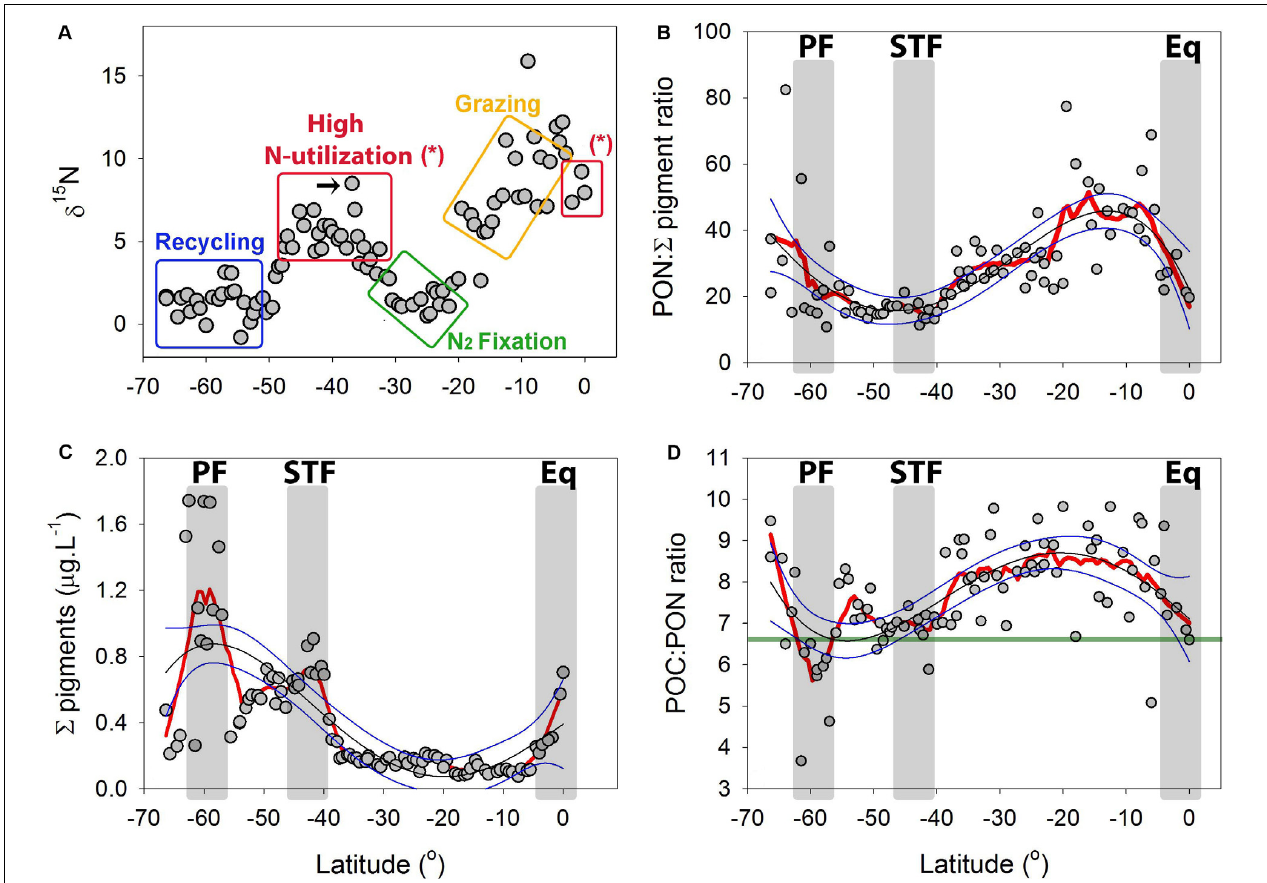
FIGURE 9 | (A) Natural abundance δ 15 N from the particulate organic matter (PON) along the P15S GO-SHIP transect in the South Pacific Ocean. Colored rectangles suggest potential biochemical pathways which may drive the variation in the δ 15 N of the POM (see a proxy for N-cycling pathways using the δ 15 N of PON in the “Discussion”). The black arrow highlights the likely role how isotopic fractionation during NO 3 − assimilation generated the high δ 15 N feature at the STF. (B) Sum of all extracted pigments ( µ g L − 1 ) along the latitudinal P15S transect. (C) PON: (cid:54) pigment ratio along the P15S GO-SHIP transect and (D) POC:PON ratios with green line showing the expected Redfield ratio of 6.6. Red lines are negative exponential smoothing curves with a first polynomial order. Thin black lines are fourth order polynomials and thin blue lines 95% confident intervals. Gray rectangles denote oceanographic fronts (PF, Polar front; STF, Subtropical Front; Eq, Equatorial upwelling